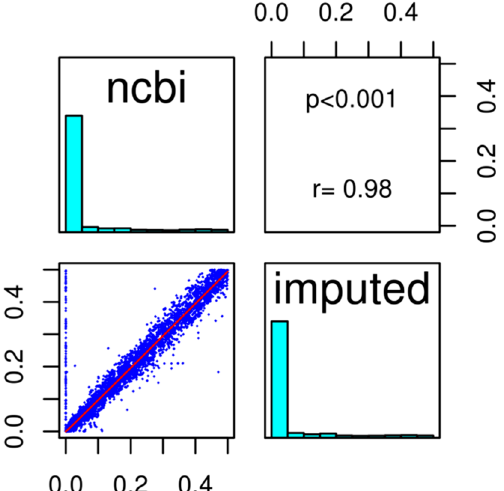
Figure 3. Correlations between the variant MAF in NCBI dbSNP137 and the MAF after imputation without pre-filtration: 163 variants (imputed-only) were recorded in NCBI with null allele frequencies (18 imputed with MAF = 0 and information score < 0.3; 145 mostly structural variants uncorrelated with their imputed MAF).